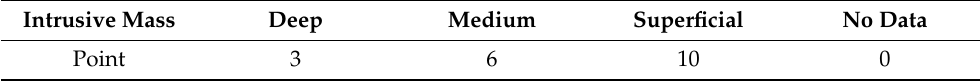
Table 4. Classification of intrusive masses for integration by multi-class index overlap method.